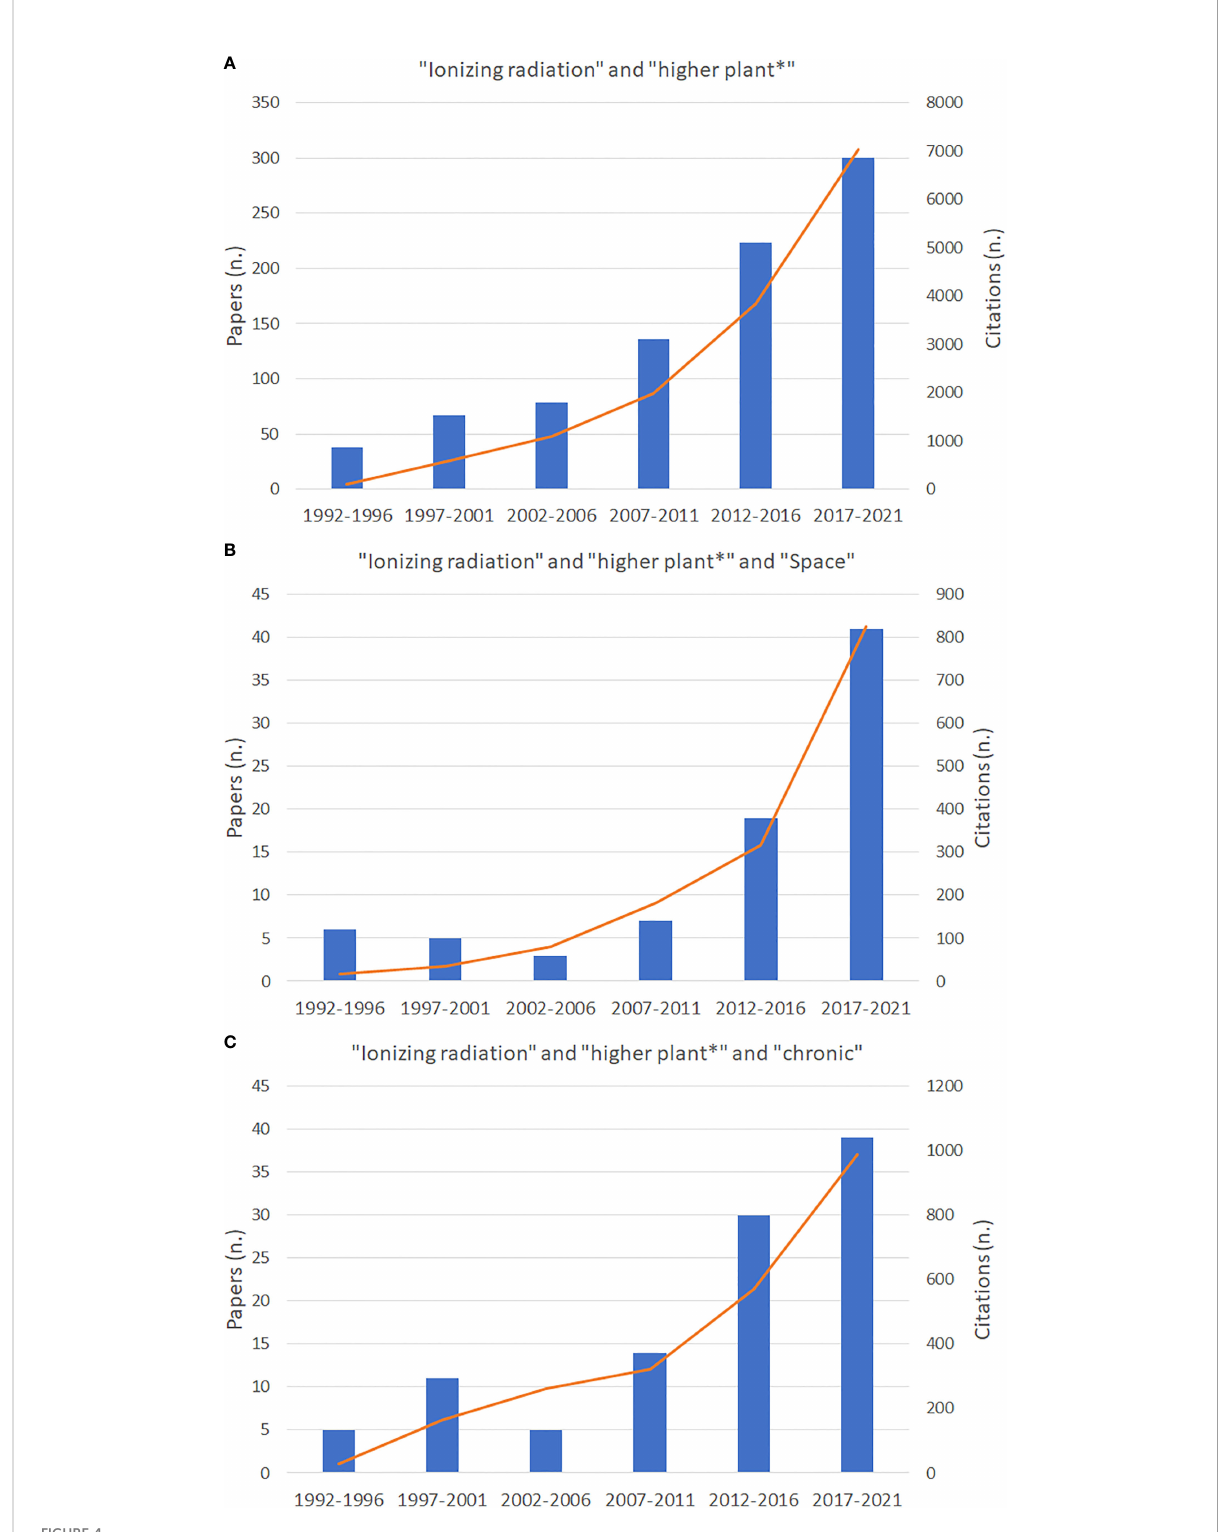
FIGURE 4 Number of papers published from 1991 to 2021 and related citations dealing with ionizing radiation and higher plants (A) , and Space (B) , and chronic radiation (C) , as indexed in the Web of ScienceTM database (Thomson